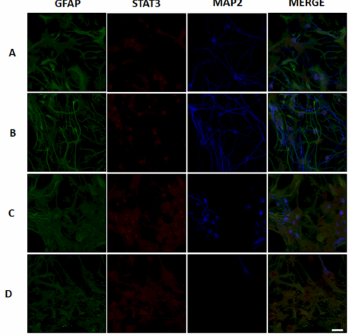
Figure A2. AG490 inhibition assay (50 µ M). Immunofluorescence representative 40 × images (scale bar 40 × images = 40 µ m) of inhibition assay in primary hippocampal cultures, after 72 h of exposition to ( A ) Vehicle, ( B ) AG490 50 µ M, ( C ) A β O 20 µ M, and ( D ) AG490 + A β O. Total STAT3 expression (Alexa 555), astrocytes with GFAP (Alexa 488), and neurons with MAP2 (Cy5) were identified. The use of